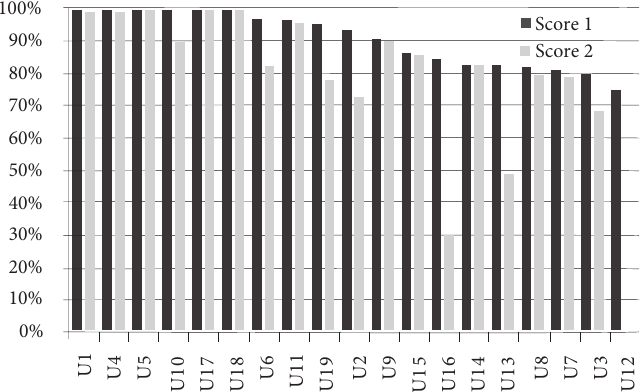
Fig. 2. University efficiency scores: Score 1 – without restrictions on the output weights, Score 2 – with restrictions on the output weights Source: Calculated by the